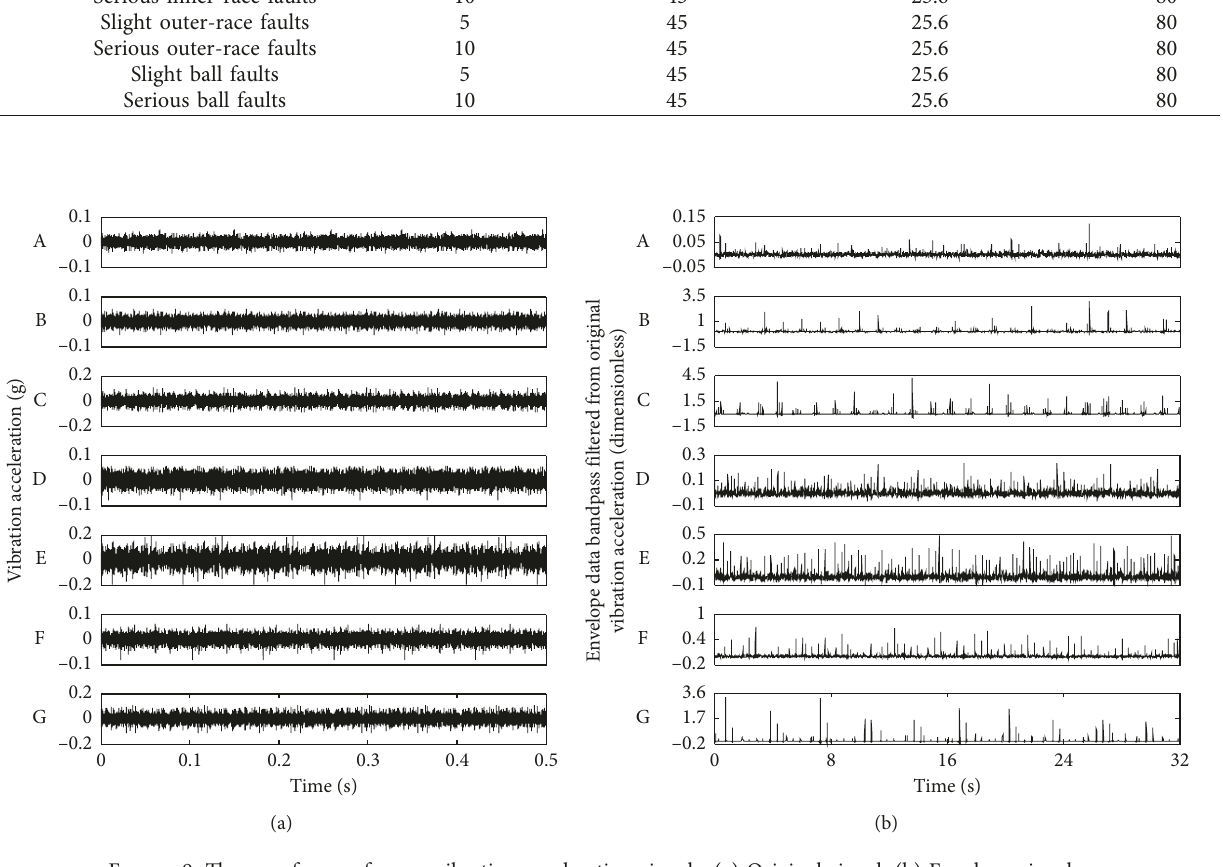
Figure 9: The waveforms of seven vibration acceleration signals. (a) Original signal. (b) Envelope